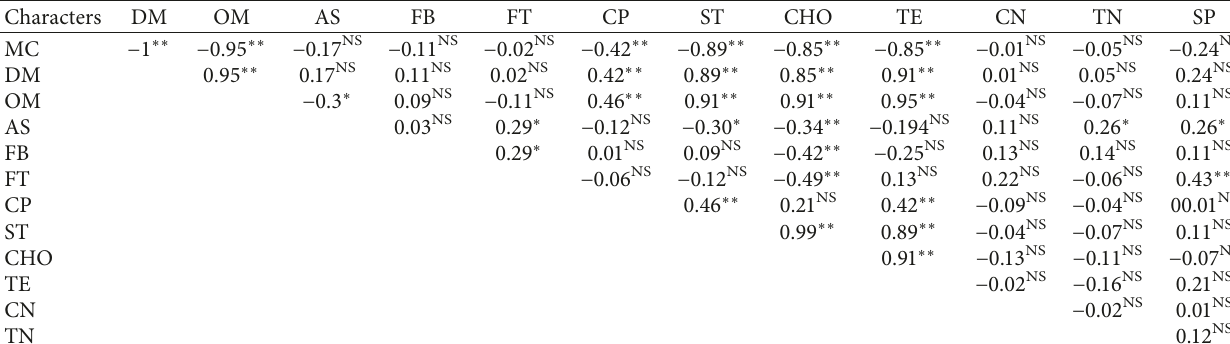
Table 5: Pearson correlation coefficients among biochemical characters.